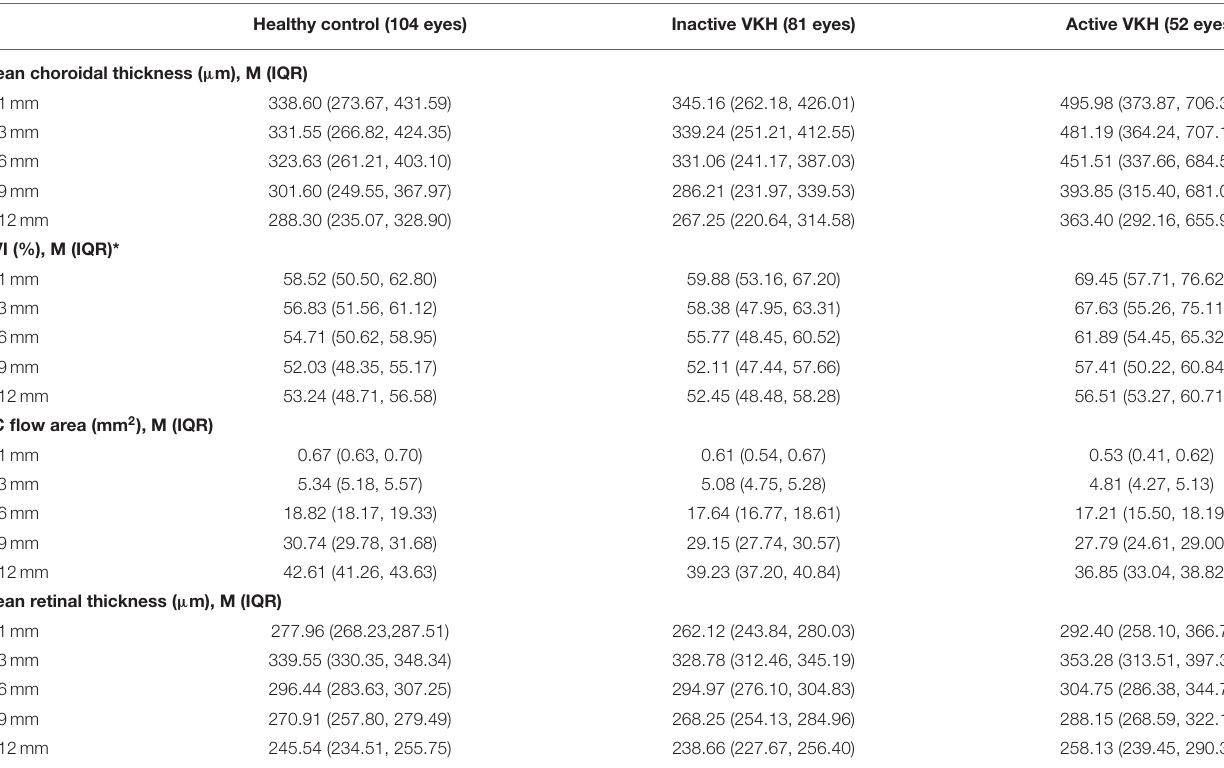
TABLE 2 | Choroidal and retinal parameters of healthy, inactive VKH, and active VKH eyes on 12mm × 12mm OCTA. Healthy control (104